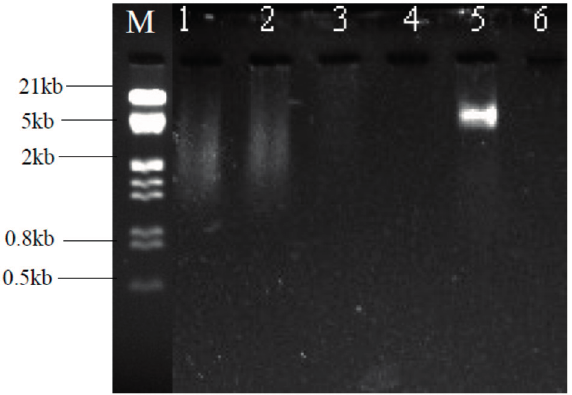
Figure 10. Plasmid profiles of wild strains of heavy metal resistant isolates and their cured derivatives. M . Lambda DNA + HindIII/EcoRI Marker; 1 . Pseudomonas sp (KR23)